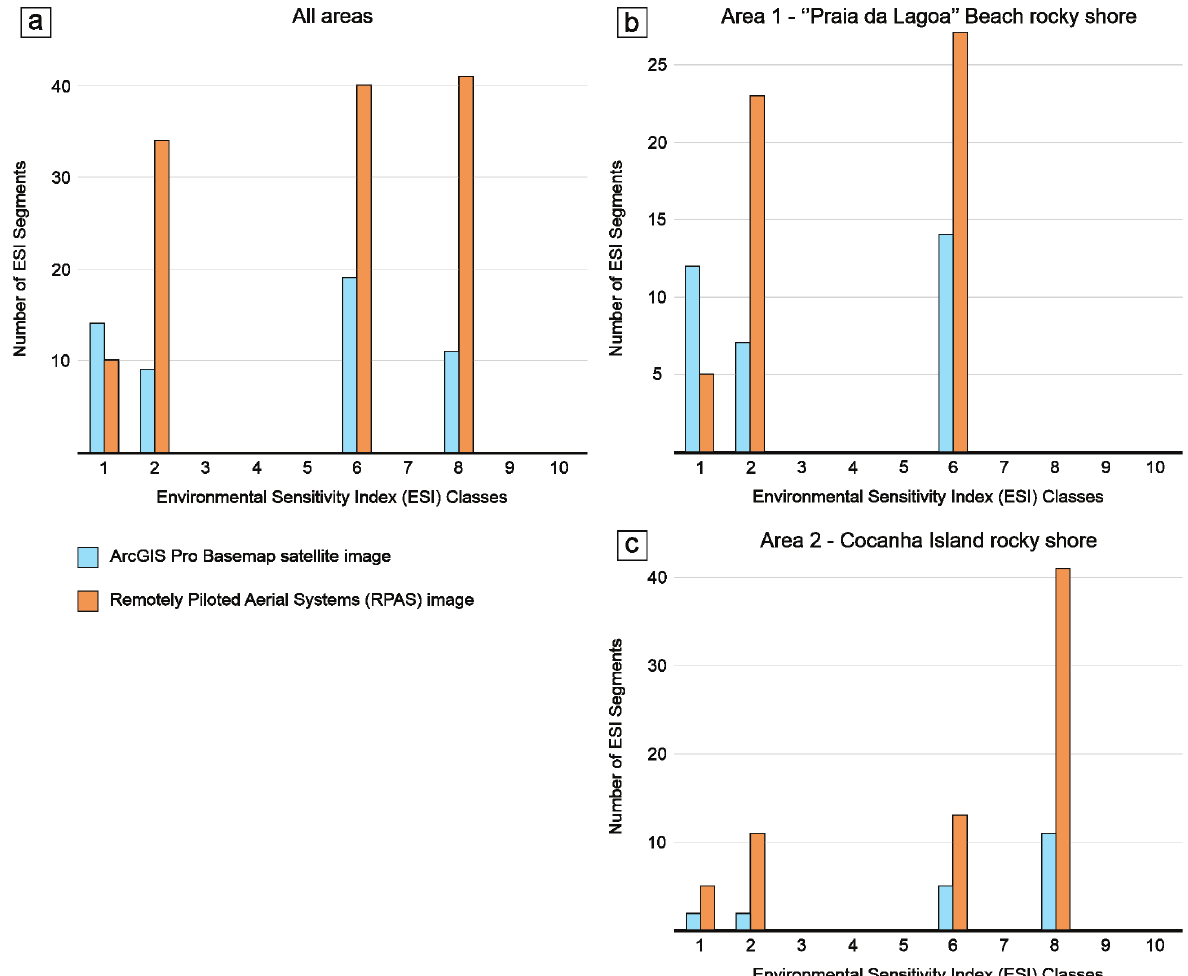
Figure 5. Bar graphs show the occurrence of regions with specific ESI values within the studies areas. (a) Occurrence of ESI values considering all the studied areas together. Occurrence of ESI values considering just (b) Area 1 (“Praia da Lagoa” Beach rocky shore) and (c) Area 2 (Cocanha Island rocky